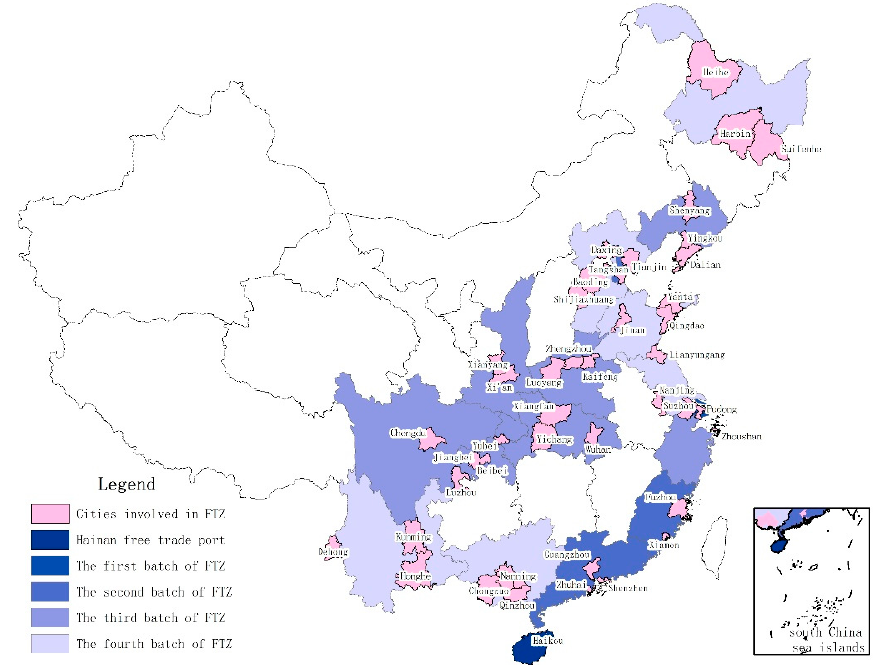
Figure 1. China’s 18 free trade zones and the cities involved.